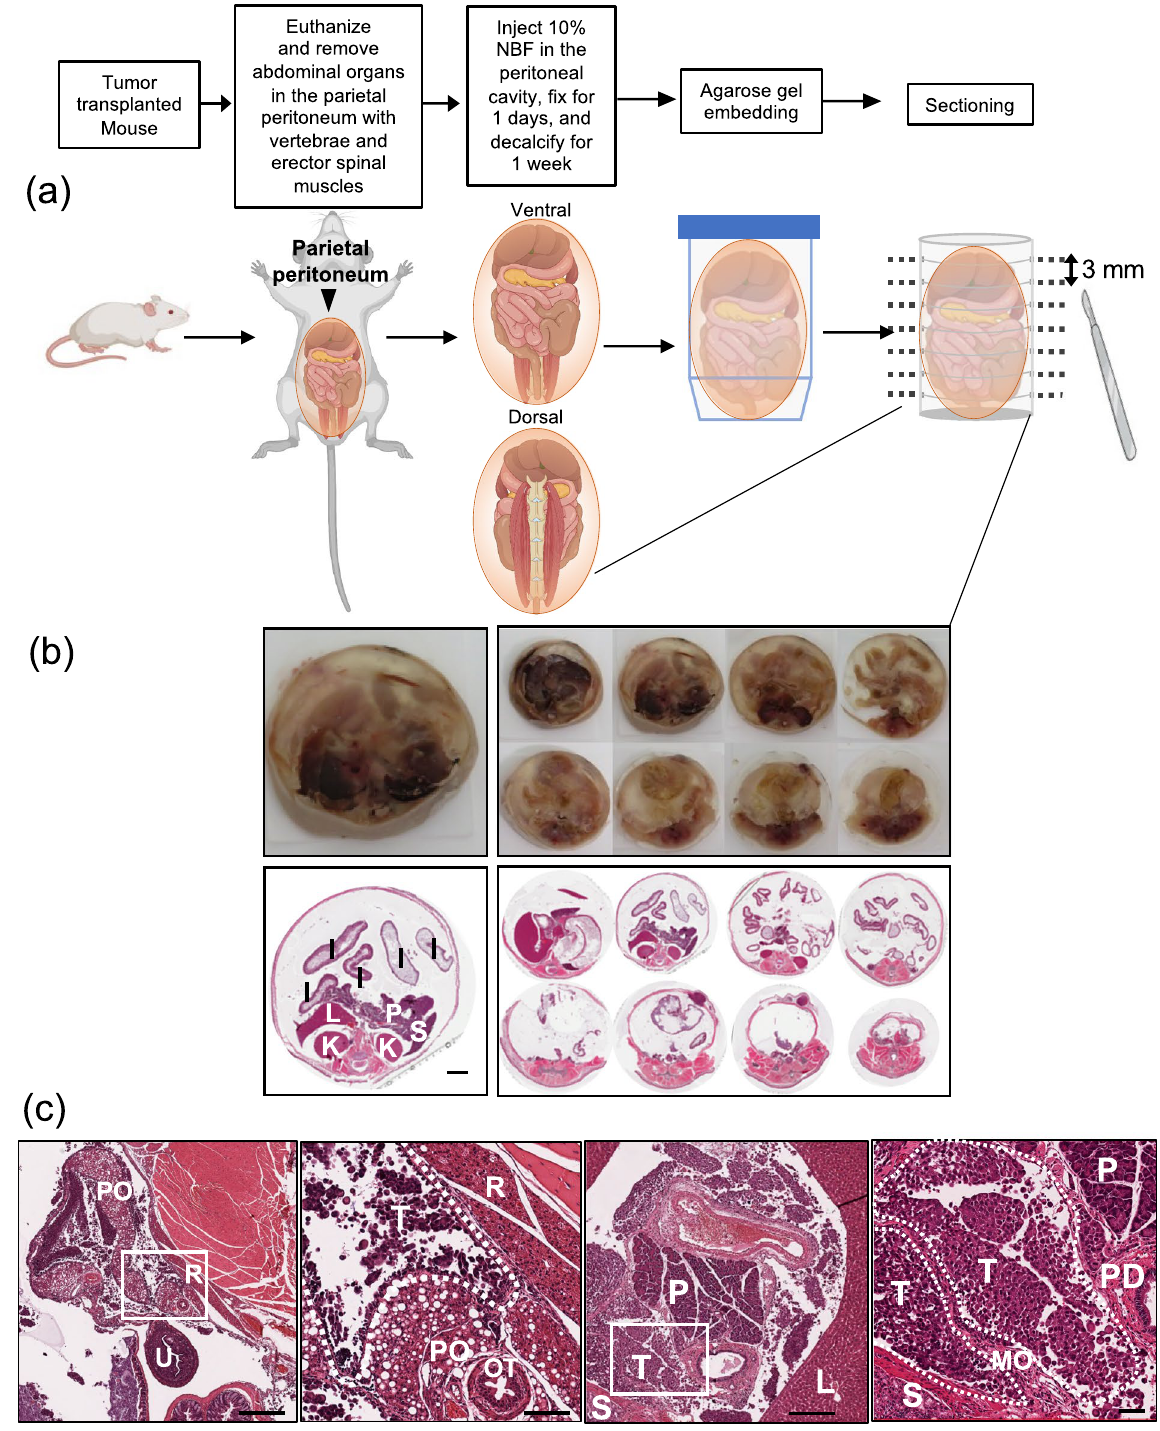
Figure 1. Spatial sectioning method and representative sectioned images. ( a ) Spatial sectioning procedure. ( b ) Preservation of spatial information pertaining to the sectioned specimens. Sectioned organs (top) and macro images of hematoxylin and eosin (H&E)-stained sections (bottom) from nude BALB/c mice with ES-2 ovarian cancer dissemination are shown. I Intestine, K kidney, L liver, P pancreas, S spleen. Scale bar: 2 mm. ( c ) Preserved metastatic niches composed of multiple organs/tissues. T disseminated cancer, U uterus, R retroperitoneal adipose tissue, PO periovarian adipose tissue, OT ovarian tube, L liver, P pancreas, PD pancreatic duct, MO major omentum, S stomach. Scale bar from left to right images: 500 µm, 100 µm, 500 µm, and 100 µm,